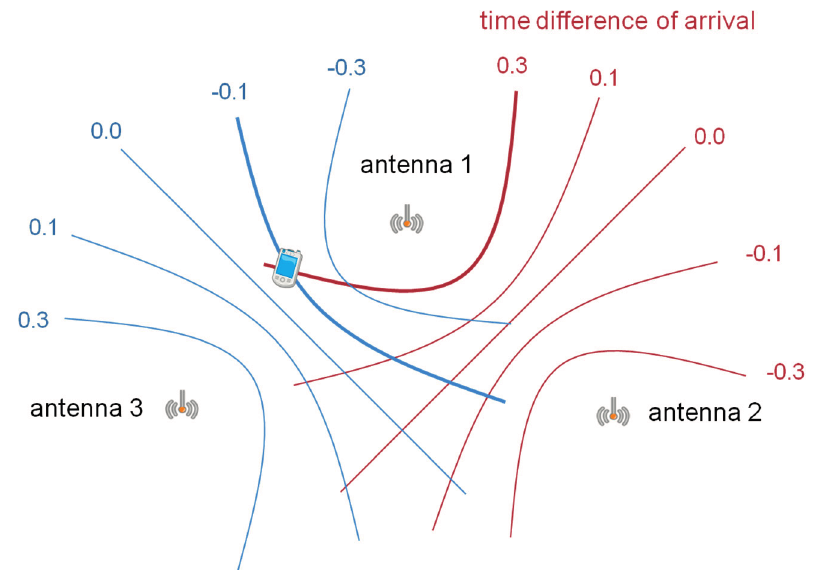
Figure 1. Concept of hyperbolic